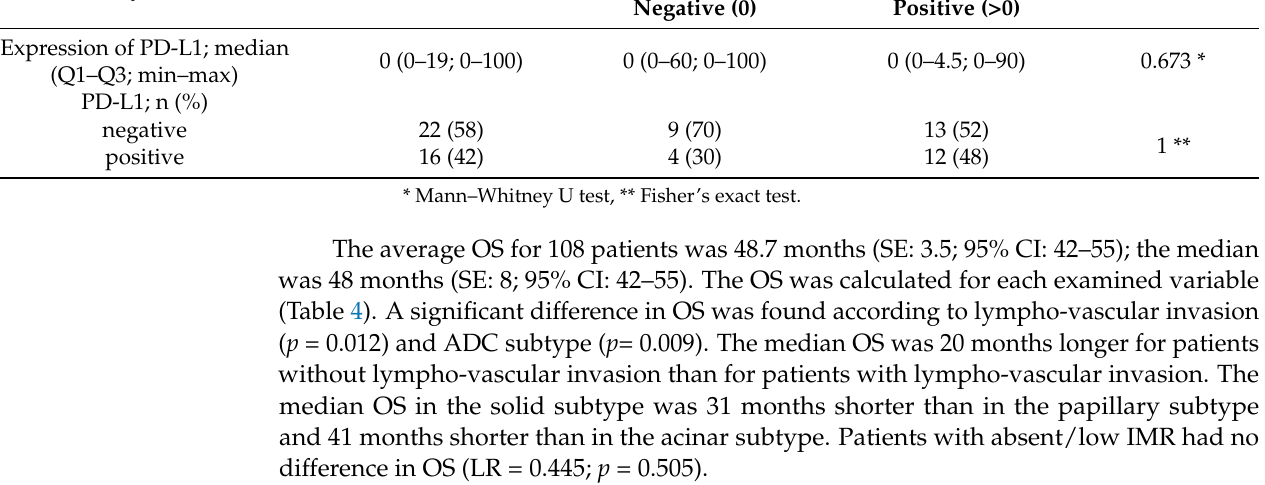
Table 3. The correlation between PD-L1 expression in cancer cells in primary tumours and metastatic lymph nodes. Primary Tumour